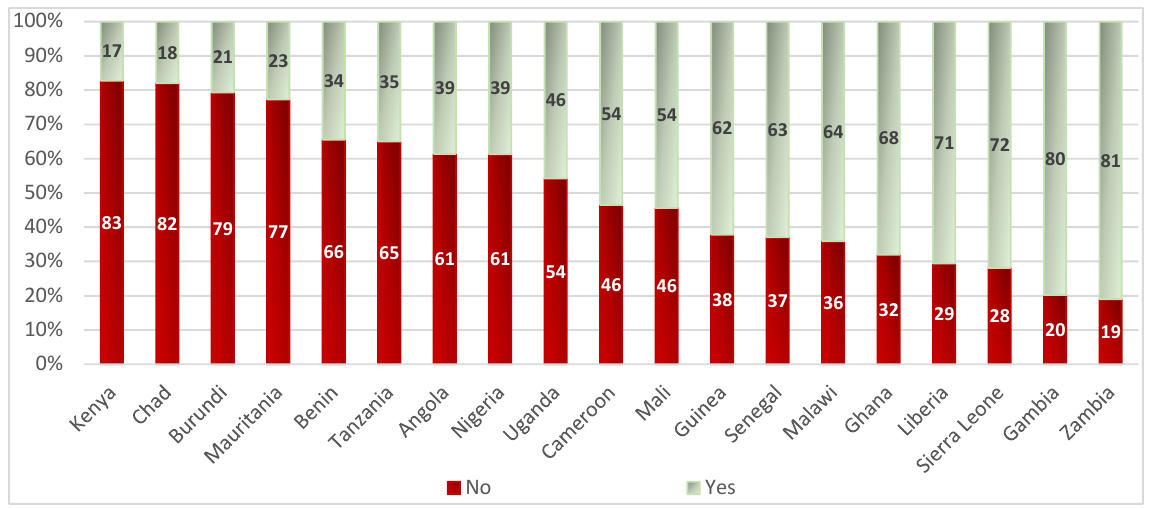
Figure 2. Distribution of malaria prophylaxis (at least two doses) by country among mothers of youngest child under two years of age.